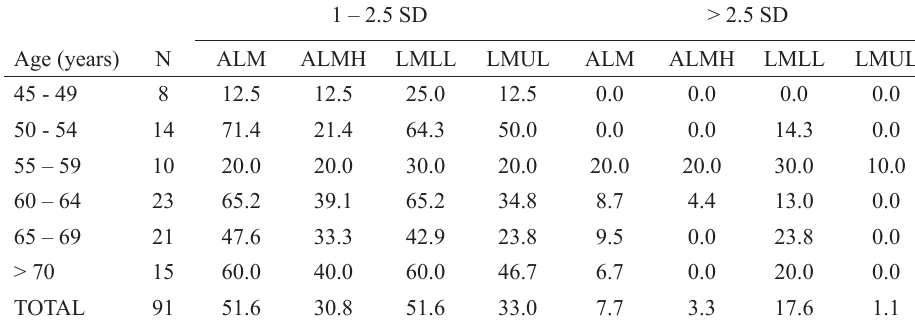
Table 3. Prevalence (%) of sarcopenia in middle-aged and elderly